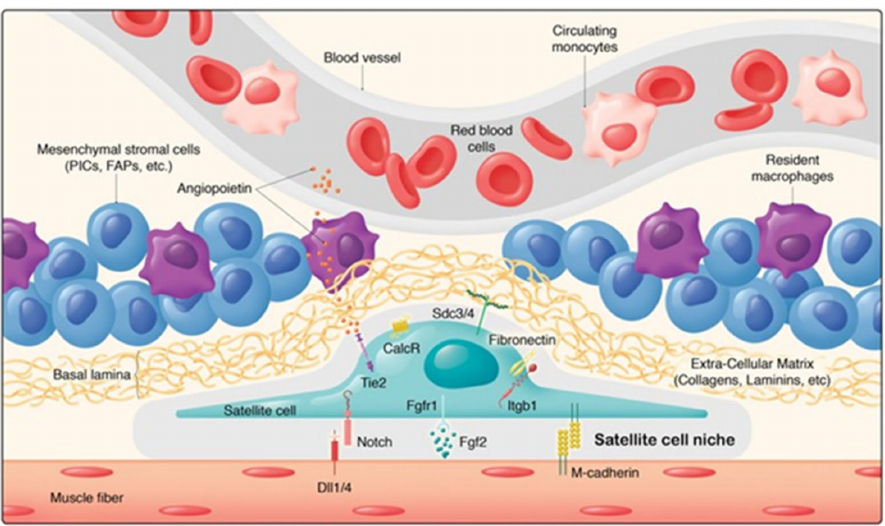
Figure 4. The satellite cell and stromal cell niche [139]. Satellite cells states are regulated through their interactions with their microenvironment. While direct interactions (M-cadherin, Notch pathway) and communication (FGF2/FGFR1 pathway) between muscle fibres and satellite cells have been identified, muscle stem cells also interact with a variety of components of the extracellular matrix (e.g., Collagens VI and V, Laminin, Fibronectin, SDC3/4) and diffusible cytokines and growth factors (e.g., Angiopoietin-Tie2 receptor). In addition to satellite cells, several cell types contribute to muscle growth, homoeostasis and regeneration, including pericytes, mesenchymal stromal cells (e.g., Pw1+ Interstitial Cells, Fibro Adipogenic Progenitors, Twist2+ cells) immune cells (e.g., resident or infiltrating macrophages) as well as connective tissue cells. Copied under the Creative Commons Attribution 4.0 International license from Evano and Tajbakhsh, 2018 [139]. SC quiescence is a specific state in that during homoeostasis, satellite cells are maintained in a reversible non-proliferating quiescent (G0) state by a number of regulators [139,154]